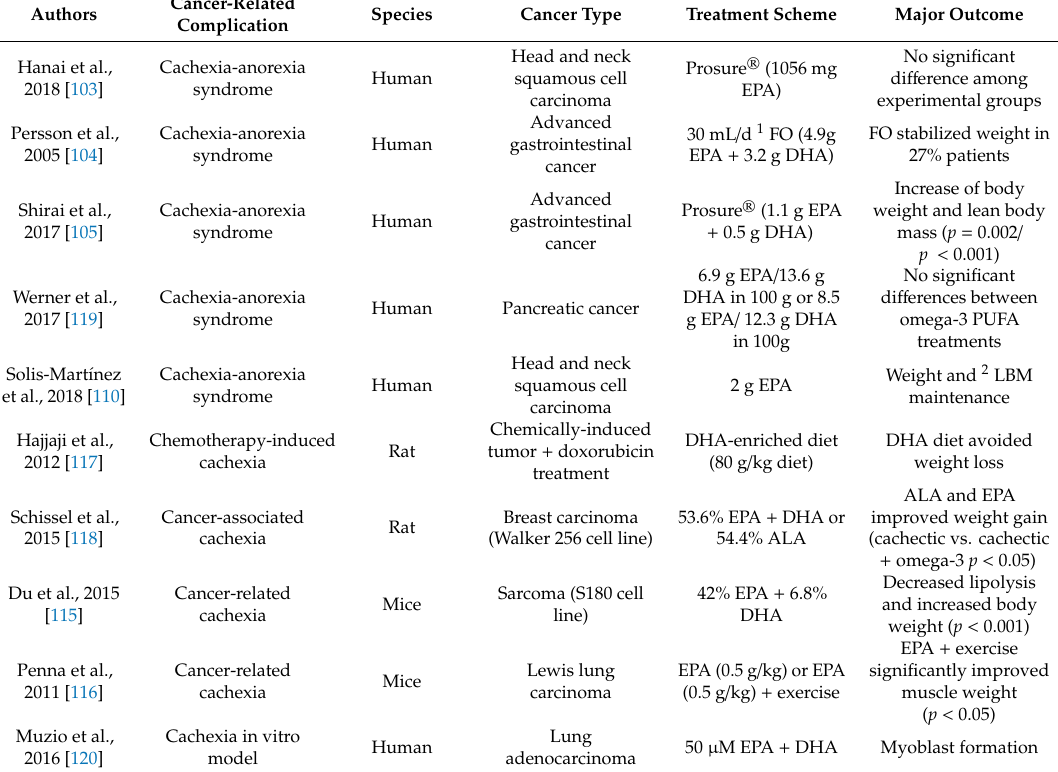
Table 2. A brief summary of the selected articles on the use of omega-3 PUFAs as a treatment for cancer-related